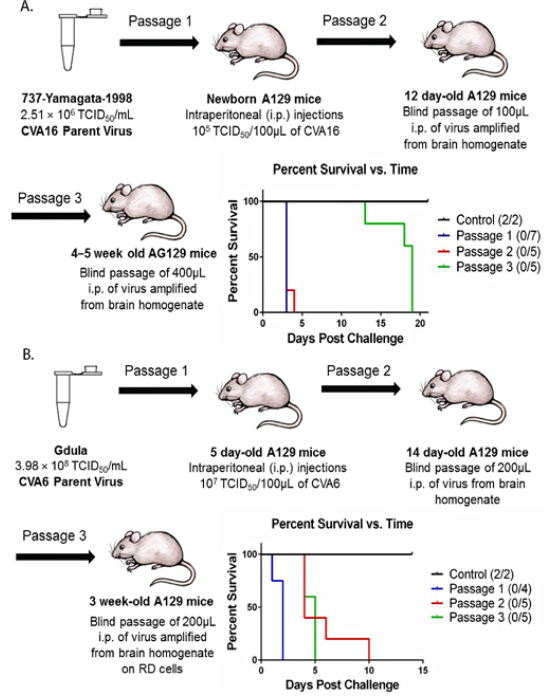
Figure 1. Timeline for mouse adaptation of CVA16 and CVA6. ( A ) CVA16 viral strain 737-Yamagata-1998 was passed three times in young A129 and AG129 mice, increasing age with each passage. Intraperitoneal (i.p.) injections were done for all viral challenges, with negative control groups receiving 1× PBS (same route and volume). All mice challenged with virus developed clinical signs of disease and succumbed to infection; ( B ) CVA6 viral strain Gdula was passed three times in young A129 mice using the same methodology described above. All mice succumbed to infection in each passage, with clinical signs developing after 10 days for the final passage.